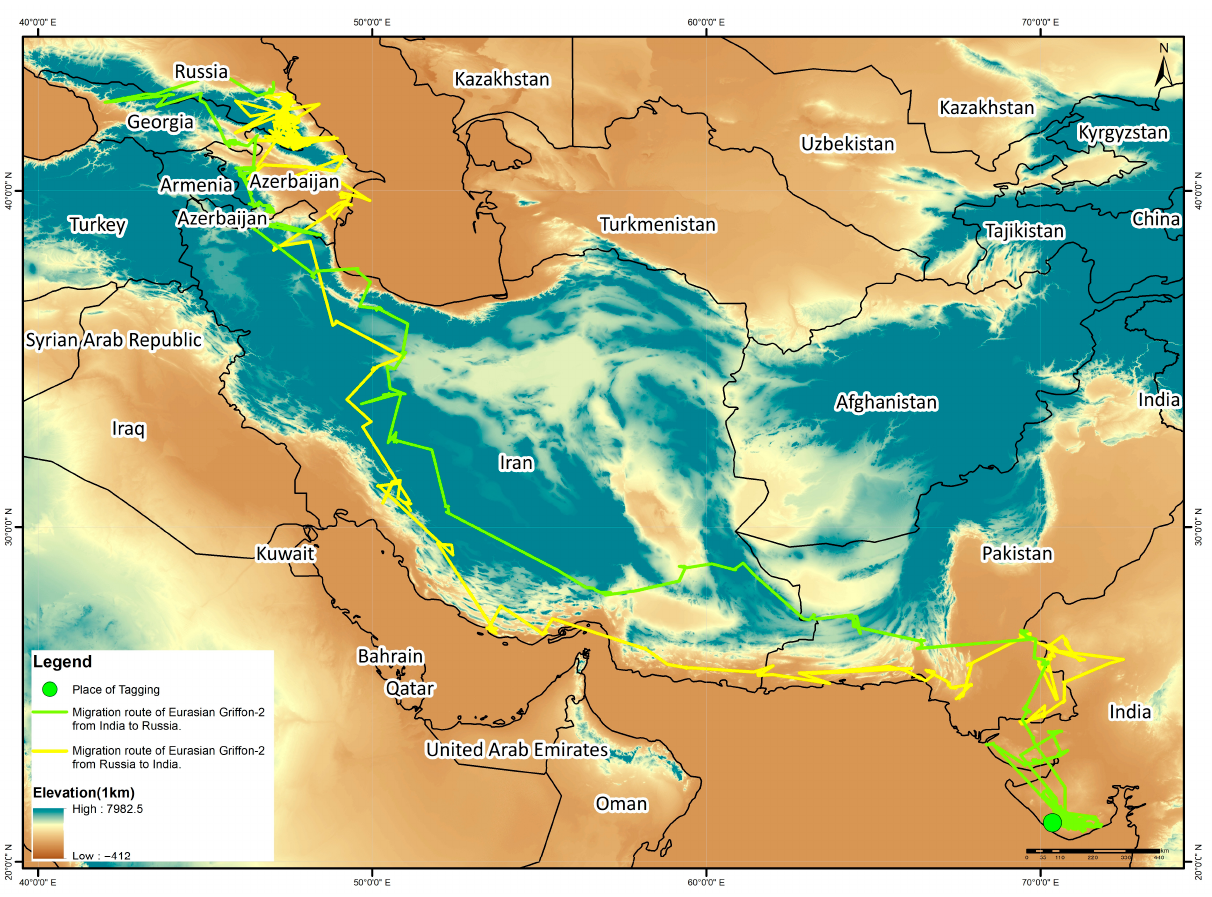
Figure 5. Migration route of Eurasian griffon-2 from Saurashtra Landscape to Russia (green line) during pre-breeding season and from Russia to India (yellow line) post-breeding season. Green dot represents the place of tagging. This map was generated using ArcGIS 10.8.1. Redlands, ESRI, California, USA. Country borders represented here are according to Google Earth imagery (Google India).